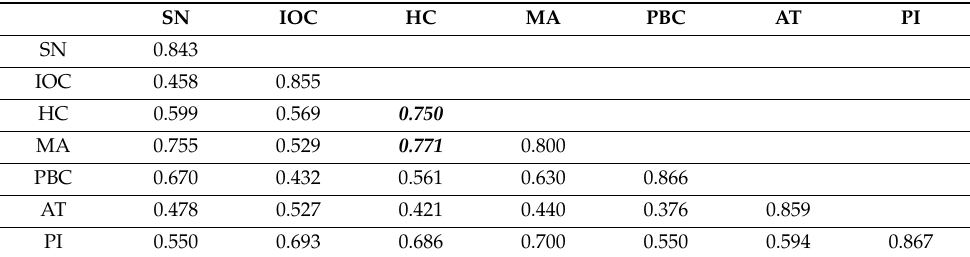
Table 4. Correlation matrix for discriminant